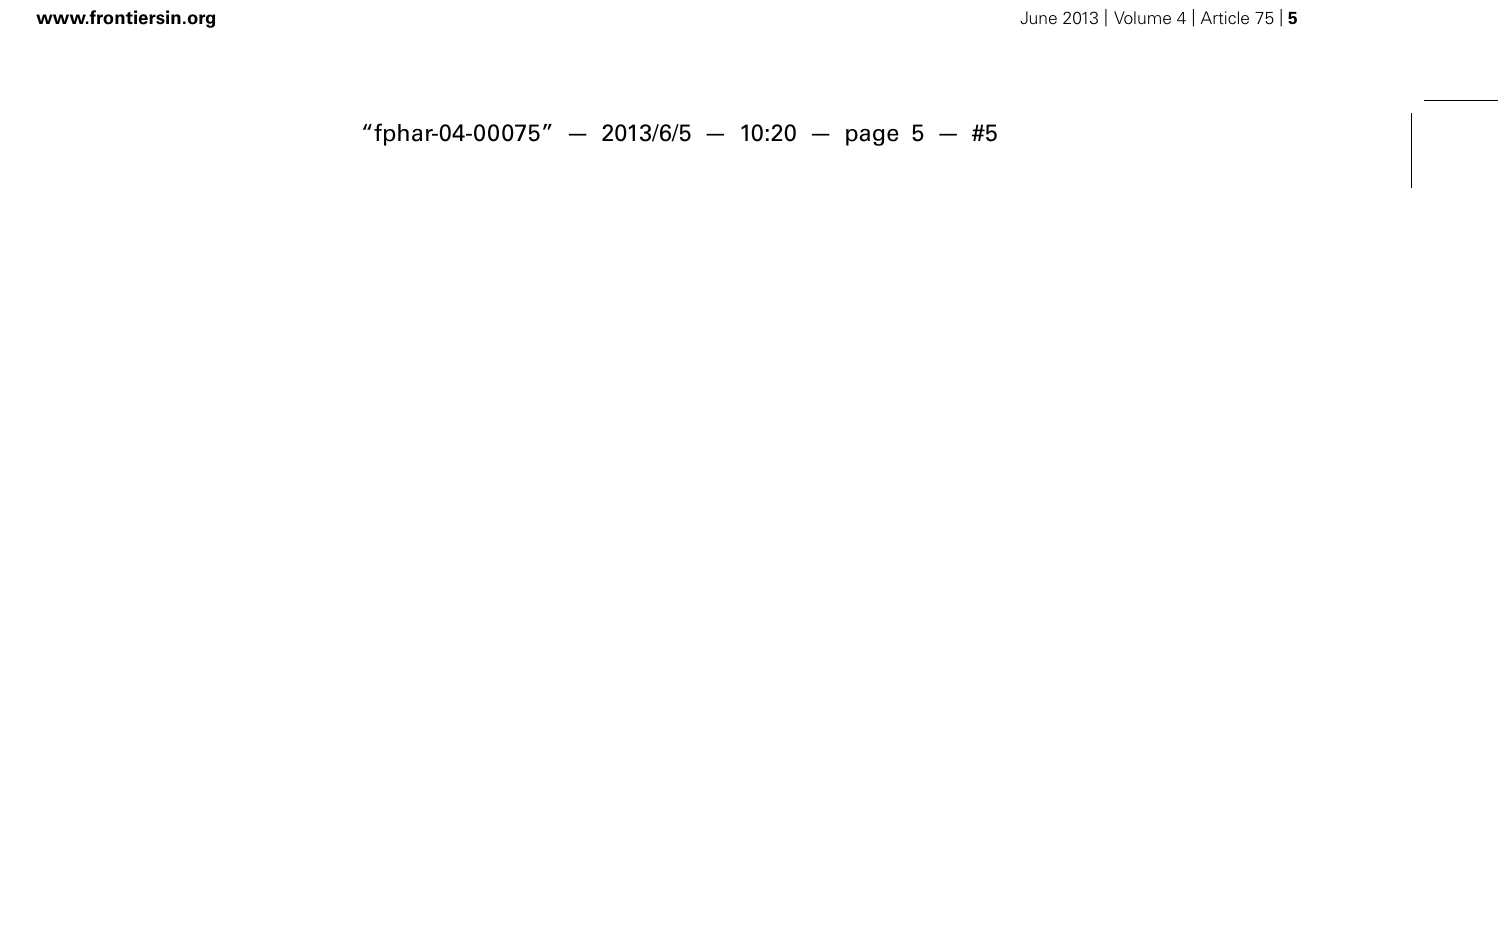
FIGURE 3 | cAMP induced activation of SpIH channels. I m elicited by hyperpolarizing pulses (A) (from − 20 to − 120 mV) in SpIH transfected HeLaCx43 cells in with both 2 mM Ca 2 + (B) and with no added Ca 2 + (C) . Schematics in the right panels of (B) and (C) illustrate the experimental conditions. In both cases the external KAsp bath solution contained 500 μ M